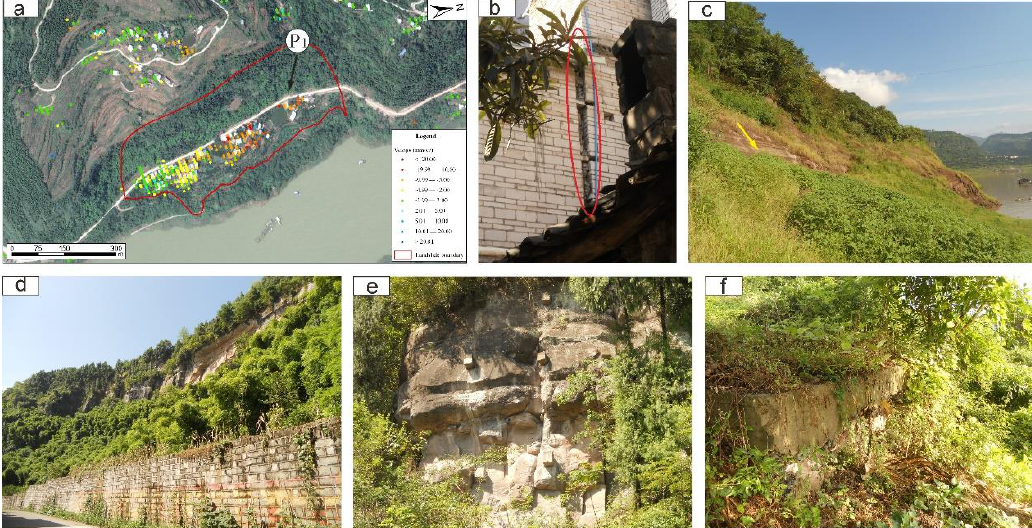
Figure 6. ( a ) PSInSAR deformation rate map of the Ertunping landslide. ( b ) Crack observed in a nearby house at site P1. ( c ) Shear crack at the front edge of the Ertunping landslide. ( d ) Retaining wall at the landslide front edge. ( e ) Anchors at the landslide trailing edge. ( f ) Anti-slide piles at the landslide front